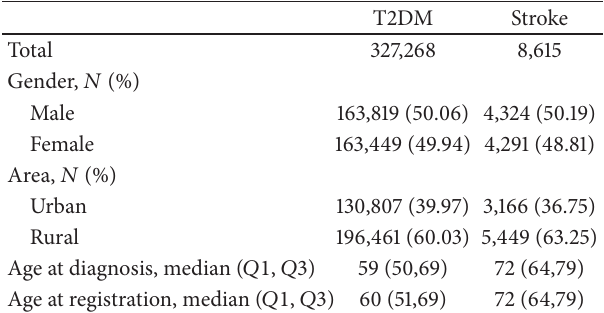
Table 1: Characteristics of the T2DM and stroke cases included in